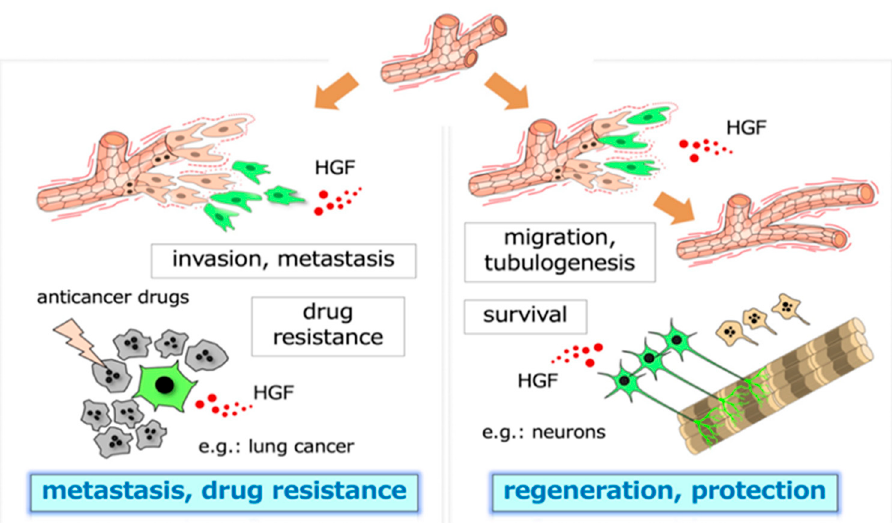
Figure 1. Two-pronged roles of HGF. The dynamic branching morphogenesis (e.g., in renal tubular cells) and the promotion of cell survival (e.g., in neurons, hepatocytes) mediated by the HGF-MET pathway play roles in tissue regeneration and protection after injury ( right panel). In tumor tissues, similar biological activities, namely, dynamic cell movement and survival, promoted by MET activation participate in invasion–metastasis and therapy resistance against molecular-targeted drugs ( left panel). The cells responding to HGF are shown in green.